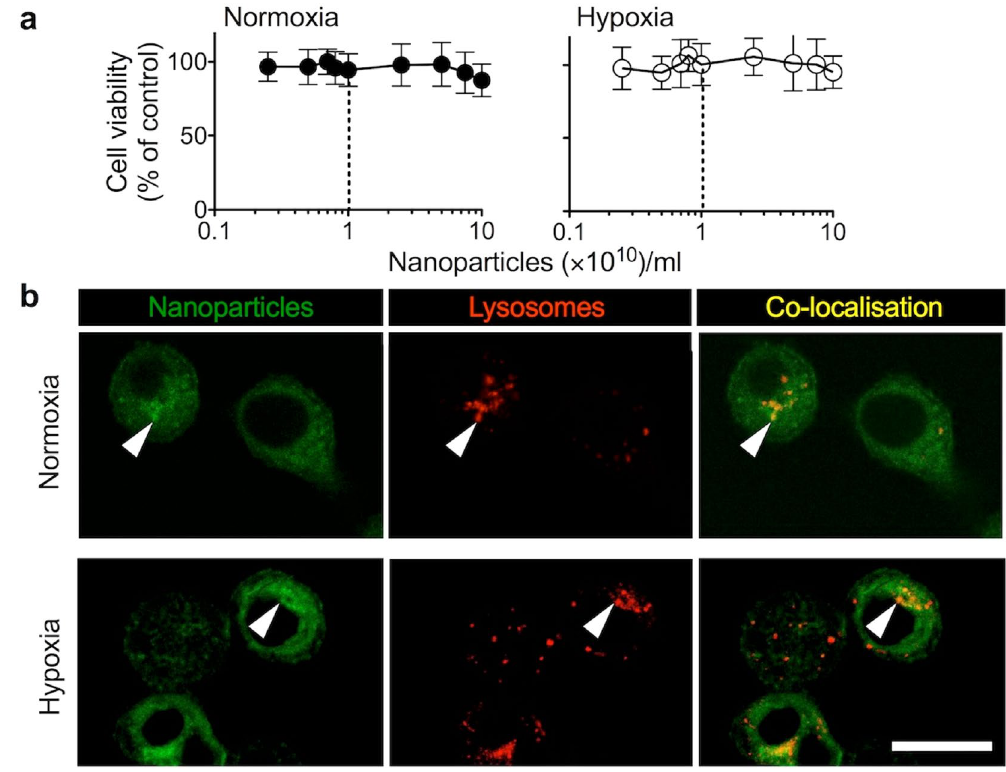
Figure 2. Cytotoxicity and uptake of nanoparticles in response to normoxia and hypoxia. ( a ) In vitro cytotoxicity of fluorescent nanoparticles in the MDA-MB-231 human breast cancer cells. Cells were dosed with fluorescent nanoparticles and subsequently cultured in either hypoxia (1% O 2 ) or normoxia. At 48 hours cell viability was assessed. Dotted lines indicate the nanoparticle dose used for subsequent studies ( n = 18 at each dosing point, from three biological replicates; ± SD). ( b ) Representative live cell confocal imaging of cells exposed for 24 hours to normoxia or hypoxia and subsequently dosed for 45 minutes with nanoparticles (green). Acidic vesicles were stained using LysoTracker Red. Arrows show nanoparticle co-localisation in acidic vesicles. Scale bar 20 μ